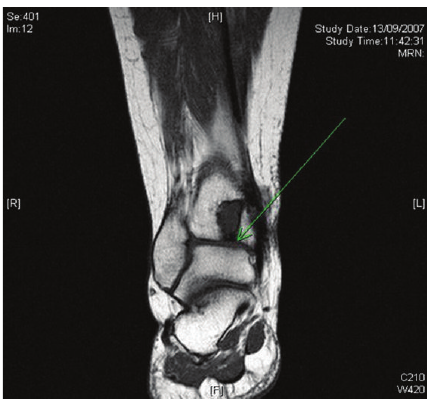
Figure 5: T1 weighted MRI showing 1.5cm intracortical, subarticu- lar cyst.